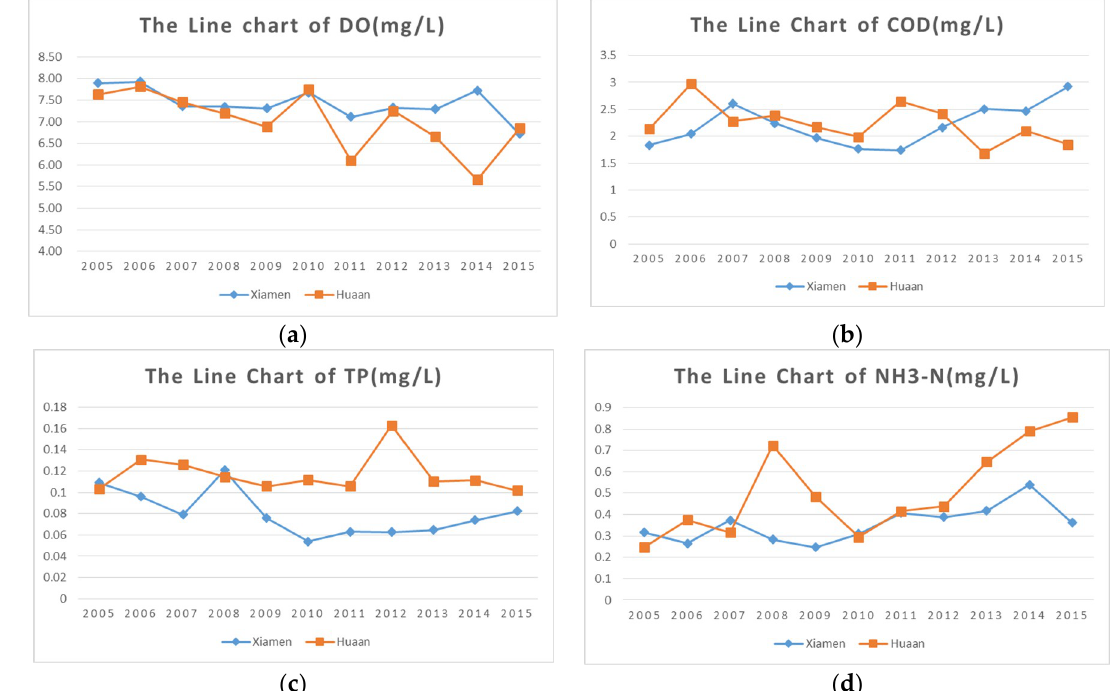
Figure 9. ( a ) The line chart of DO monitoring data in Xiamen and Hua’an from 2005 to 2015. ( b ) The line chart of COD Mn monitoring data in Xiamen and Hua’an from 2005 to 2015. ( c ) The line chart of TP monitoring data in Xiamen and Hua’an from 2005 to 2015. ( d ) The line chart of NH 3 -N monitoring data in Xiamen and Hua’an from 2005 to 2015.